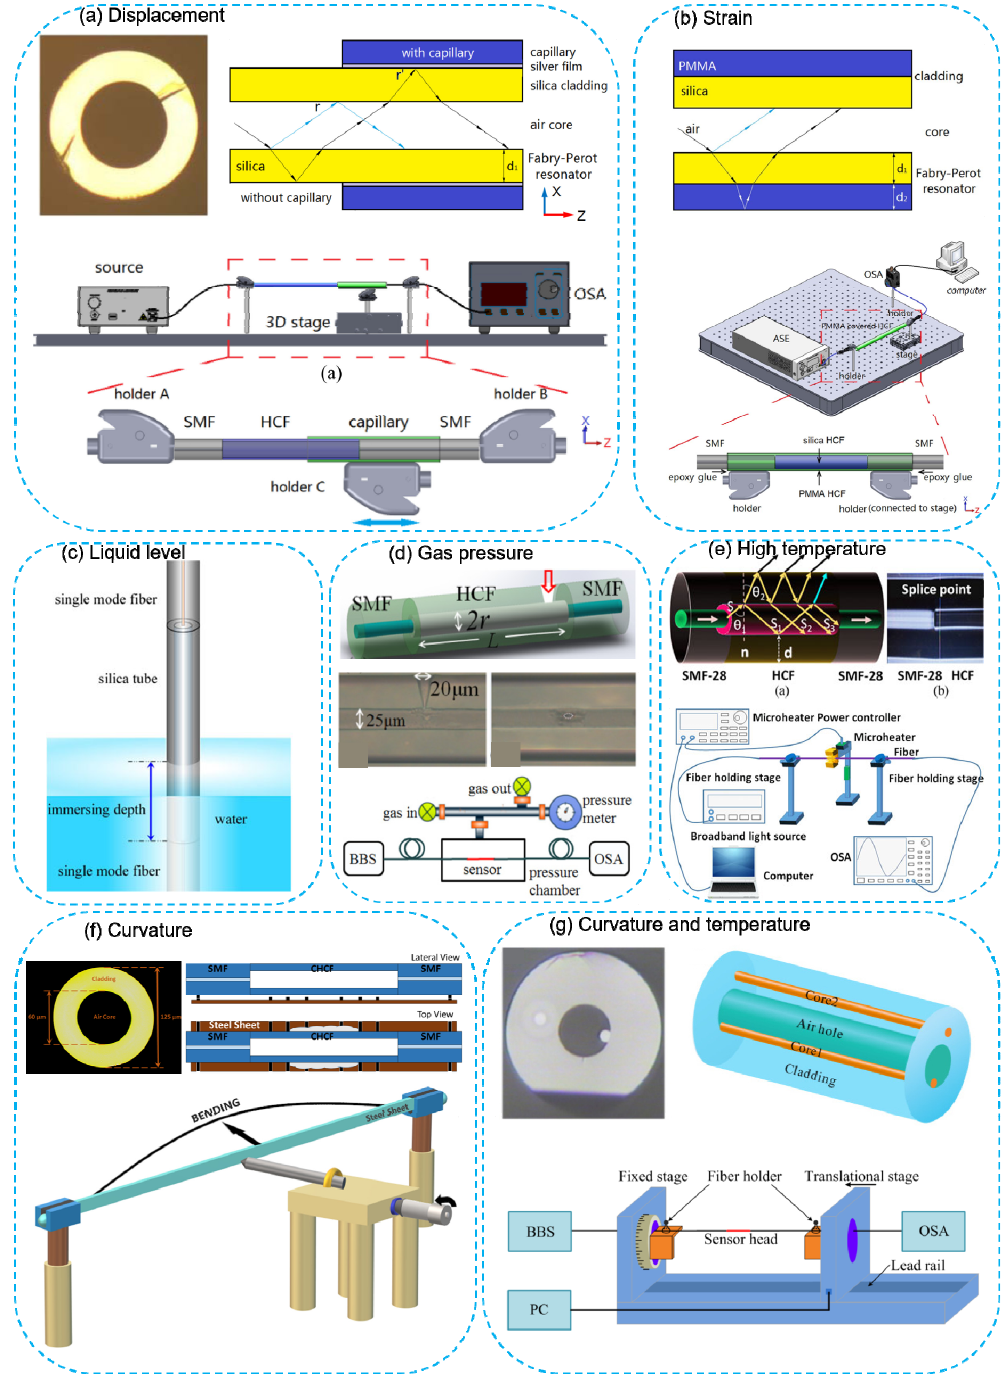
Figure 4. Special device-based sensing applications. ( a ) © 2016 IEEE. Reproduced with permission from R. Gao, J. Sel. Top Quant. 23, 5,600,106 (2016) [51]. ( b ) © 2017 IEEE. Reproduced with permission from R. Gao, IEEE Photonic. Tech. L. 29, 857-860 (2017) [52]. ( c ) © 2015 IEEE. Reproduced with permission from S. Liu, J. Lightwave Technol. 33, 5239-5243 (2016) [53]. ( d ) [Reprinted/Adapted] with permission from [54] © The Optical Society. ( e ) © 2018 IEEE. Reproduced with permission from D. Liu, J. Lightwave Technol. 36, 1583-1590 (2018) [55]. ( f ) Reproduced with permission [56]. Copyright 2020 MDPI. ( g ) [Reprinted/Adapted] with permission from [57] © The Optical